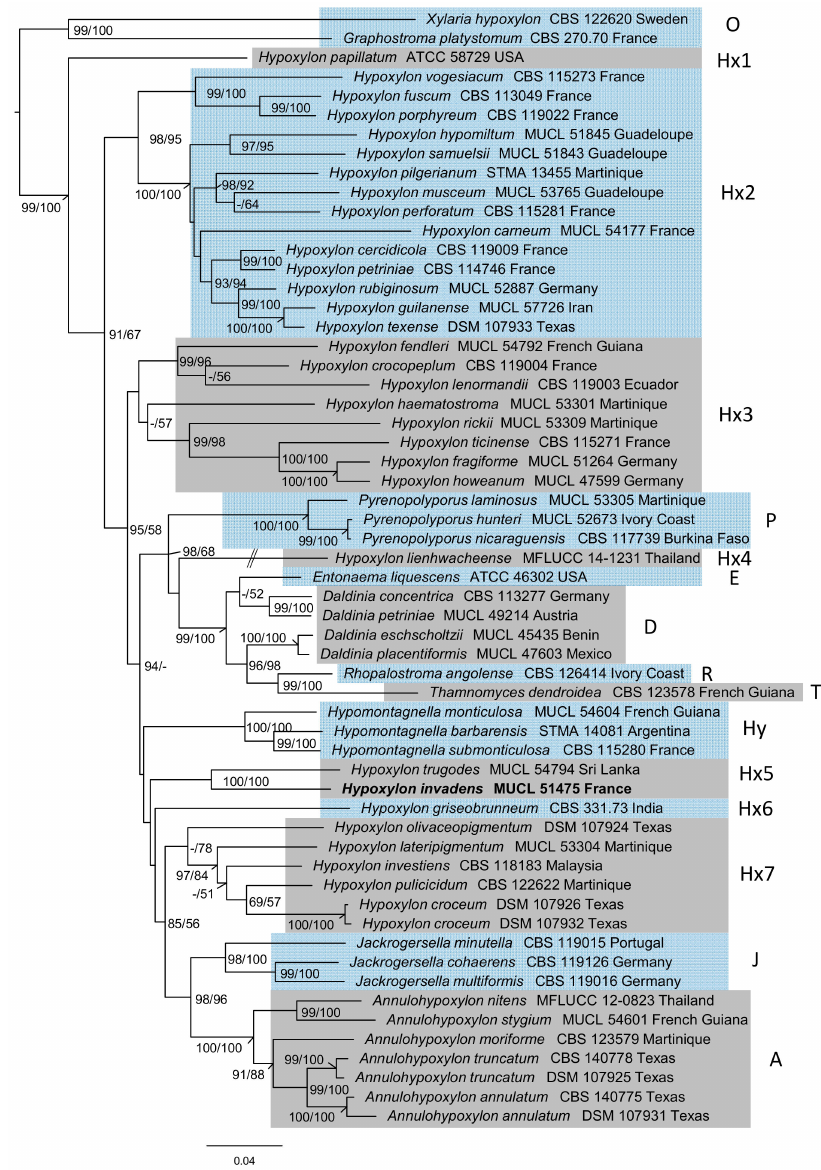
Figure 1. Inferred maximum-likelihood (lLn = − 40,100.7533) tree of a molecular phylogeny of sequenced loci of ribosomal origin (ITS, LSU) and proteinogenic genes (RPB2, TUB2), with partition-wise assigned evolutionary models. SH-aLRT ( > 85%) and BS ( > 50%) support is given at first and second position at respective branches. The labeled clades correspond to the genera Annulohypoxylon (A), Daldinia (D), Entonaema (E), Hypoxylon (Hx 1 − 7), Hypomontagnella (Hy), Jackrogersella (J), Pyrenopolyporus (P), Rhopalostroma (R), Thamnomyces (T) and the rooted outgroup (O). The clades have been highlighted by alternative grey and light blue background to allow for easier distinction. The position of H. invadens is highlighted in bold. Note: The branch length of H. lienhwacheense has been truncated, as indicated. Branch length equals substitutions per